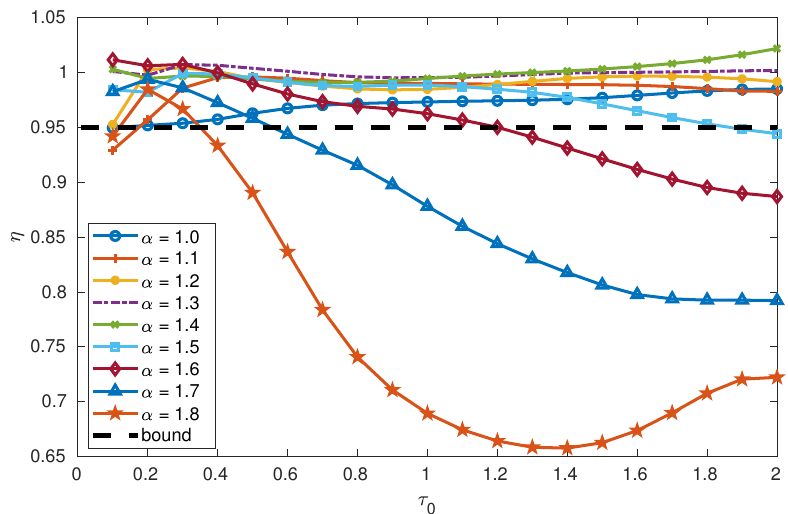
Figure 6. Index η for FOPID controllers with M t